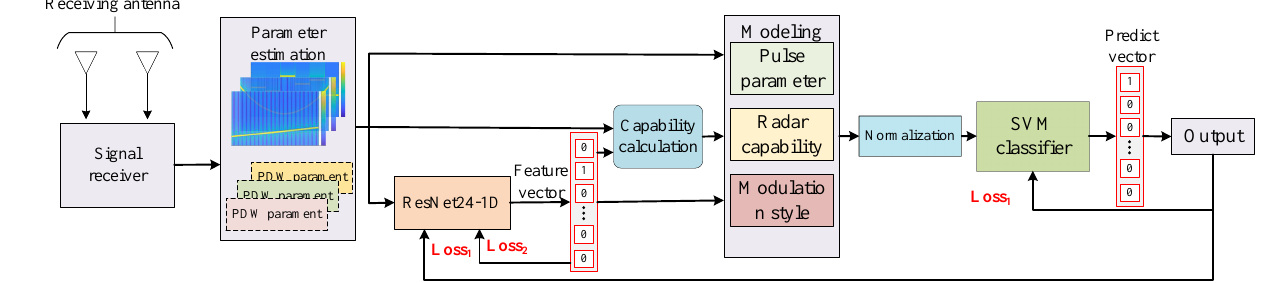
Figure 4. The architecture of the proposed MSJR. In the modeling module, Pulse parameter repre- sents the modeling information of the original pulse parameters, Radar capability represents the calculated performance indicators such as typical detection range, resolution, ambiguity resolution, etc. Modulation style represents the pulse change rules identified by ResNet24-1D, such as constant, sliding, stagger,